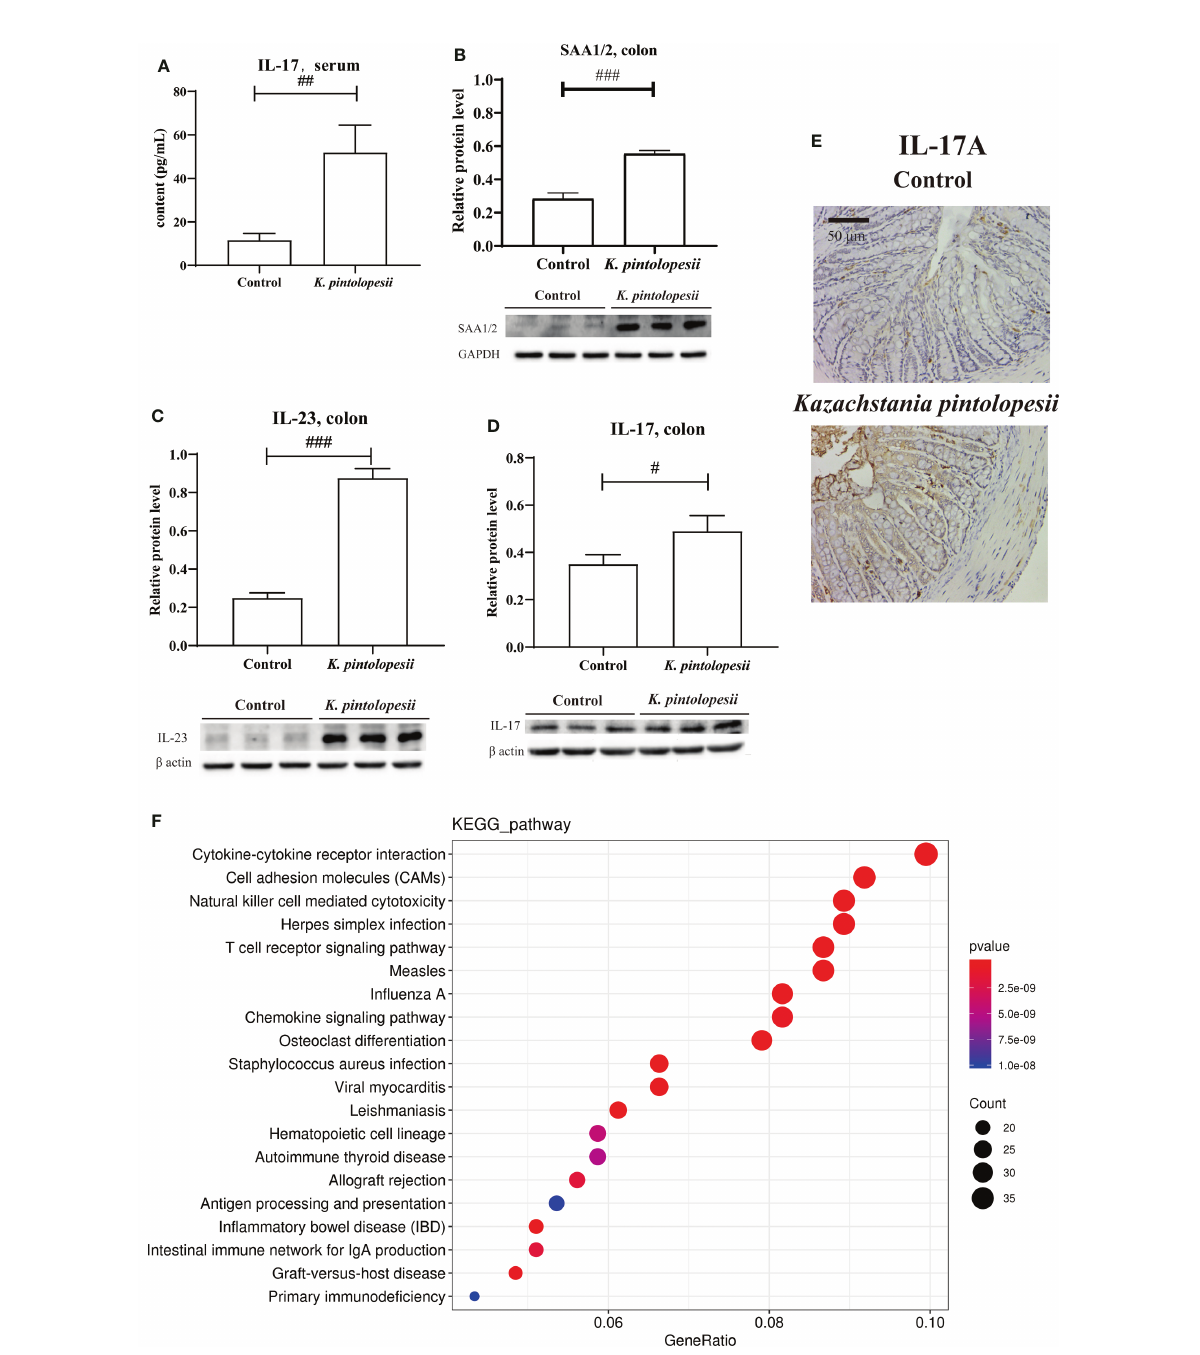
FIGURE 4 K pintolopesii induces multiple AS immune activation phenotypes in mice. (A) K pintolopesii upregulates the levels of IL-17 in serum ( p< 0.05). (B) K pintolopesii upregulates the expression of SAA1/2 in colon tissues ( p< 0.05). (C) K pintolopesii upregulates the expression of IL-23 in colon tissues ( p< 0.05). (D) K pintolopesii upregulates the expression of IL-17 in colon tissues ( p< 0.05). (E) The expression of IL17A in colon tissue was detected by immunohistochemistry. (F) KEGG analysis of differentially expressed genes showed that the pathways of cytokine – cytokine receptor interaction , cell adhesion molecules (CAMs), natural killer cell-mediated cytotoxicity , Herpes simplex infection , T-cell receptor signaling pathway , measles , in fl uenza A , chemokine signaling pathway , osteoclast differentiation , autoimmune thyroid disease , and in fl ammatory bowel disease (IBD) were enriched pathways ( p< 0.05). # p < 0.05, ## p < 0.01, ### p <